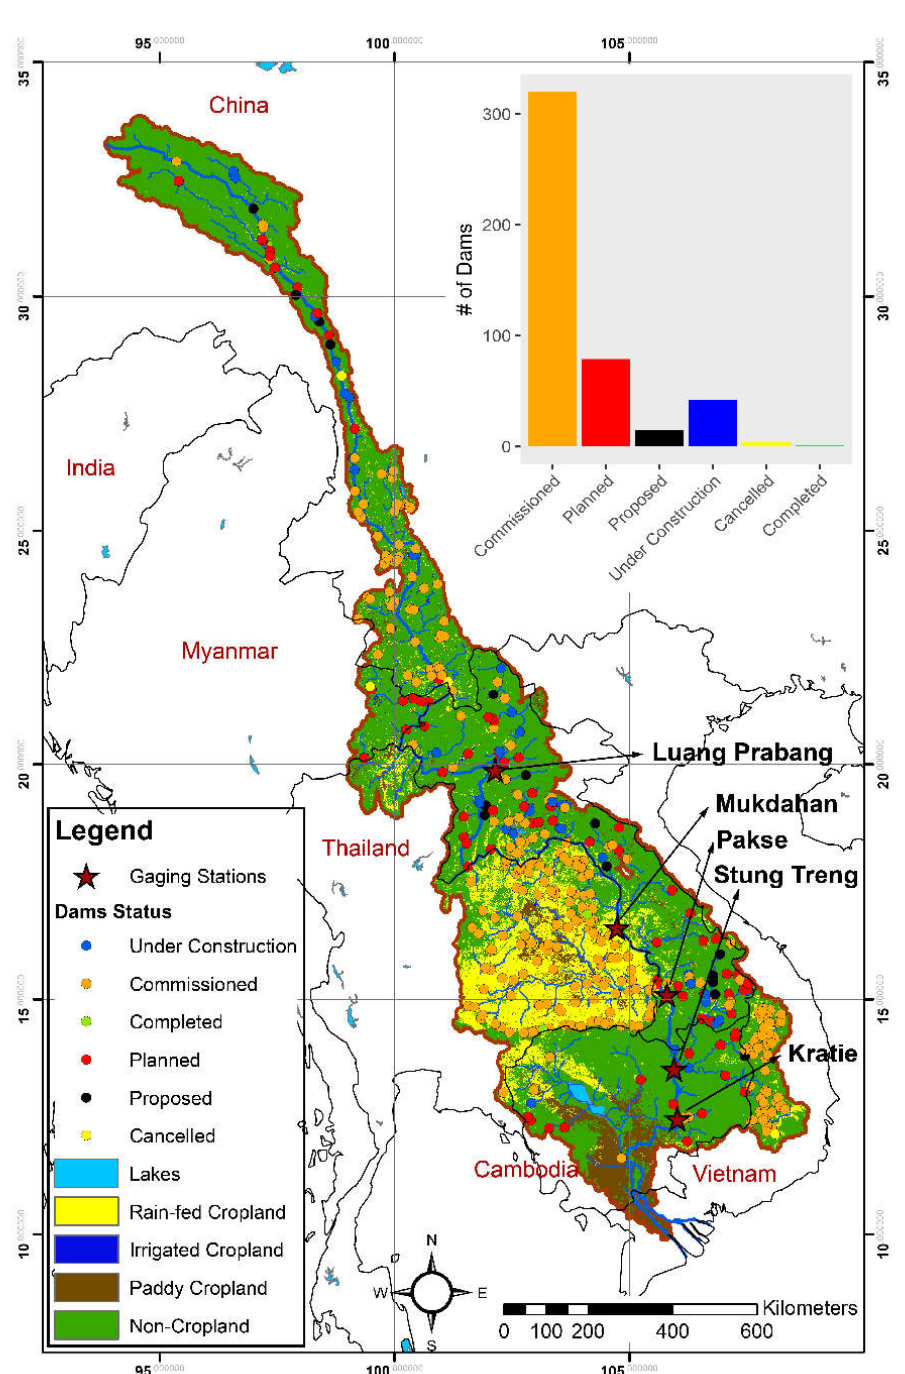
Figure 1. Dams in the Mekong river basin. The background shows land use types and irrigated croplands obtained from Salmon et al. [11]. The inset shows the number of dams under different categories with identical color coding as for the circles in the map. The location of river gauging stations for which river discharge is shown in Figure 2 are displayed as red stars. The dam database was provided by the Research Program on Water, Land, and Ecosystems (WLE), Greater Mekong.